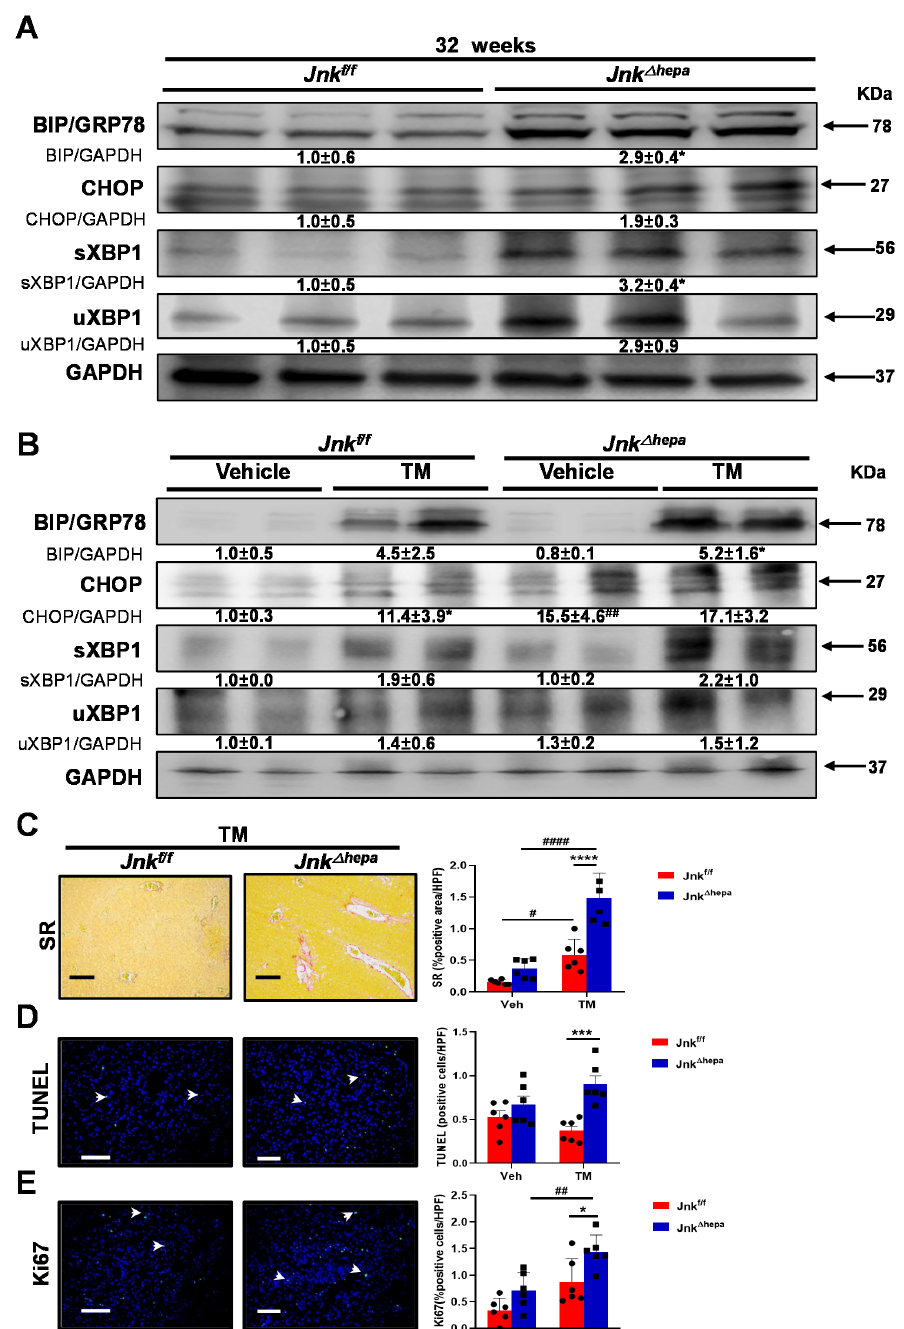
Figure 4. Activation of the unfolded protein response (UPR) triggers increased liver injury in Jnk ∆ hepa mice. ( A ) The expression of BiP/GRP78, CHOP, spliced XBP1 (sXBP1) and unspliced XBP1 (uXBP1) was evaluated in 32-week-old Jnk f/f and Jnk ∆ hepa mice using Western blot. ( B ) The expression of the same proteins was measured in Tunicamycin (TM)-challenged Jnk f/f and Jnk ∆ hepa mice. Numbers denote molecular weight (KDa) of proteins. GAPDH served as loading control. #/* p < 0.05 intra- and intergroup significance, respectively. ( C ) Representative Sirius Red (SR) stainings of liver tissue from the indicated mice after TM treatment. Scale bars, 500 µ m. ( D ) TUNEL staining was performed to assess apoptotic cell death in the same samples by IF. Scale bars, 50 µ m. ( E ) Ki67 was used to measure cell proliferation after TM treatment in the experimental groups. Scale bars, 50 µ m. Data were represented as the mean ± SEM and graphed ( n = 3–6 mice per group;*/# p < 0.05; ## p < 0.01; *** p < 0.001; ****/#### p <